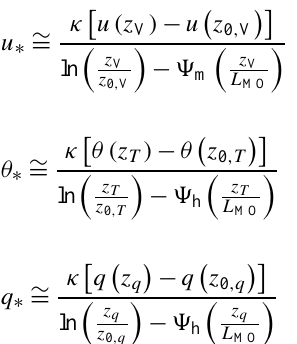
while snowdrift sublimation is retrieved through averaging three different parameterisations for snowdrift sublimation. Details of the method are given